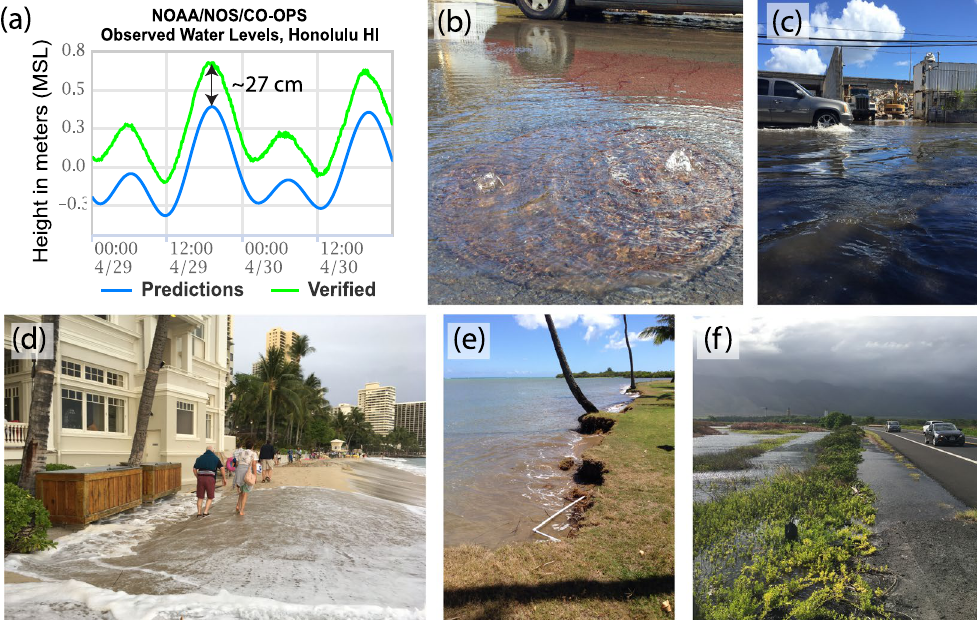
Figure 1. Between April–August, 2017, an episodic sea level anomaly, combined with long-term SLR triggered ( a ) up to ~27 cm of difference between predicted tides and observed water levels 66 . This heightened water level led to ( b ) salt water intruding storm drains, ( c ) urban flooding, ( d ) wave inundation (Waikīkī, O‘ahu), ( e ) episodic erosion (exposing a watering system), and ( f ) roadway flooding near wetlands due to